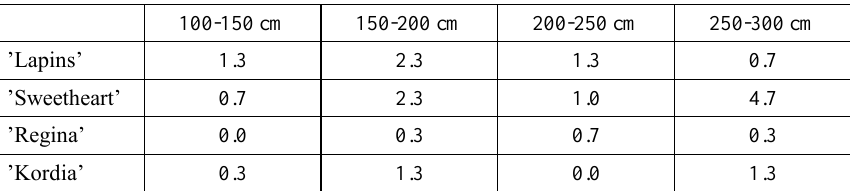
Figure 2. Thickness of the branches emerging from the central axis in different height zones (Debrecen – Pallag, 2017) Table 4 : Number of bouquets of spurs in the central axis in different height zones (Debrecen – Pallag, 2017)